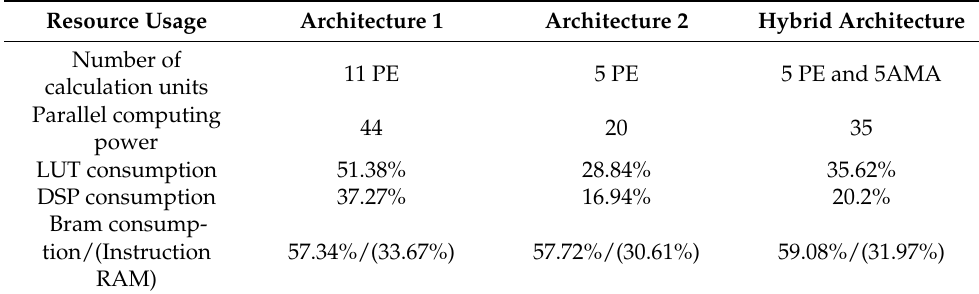
Table 2. Architecture design scale and resource